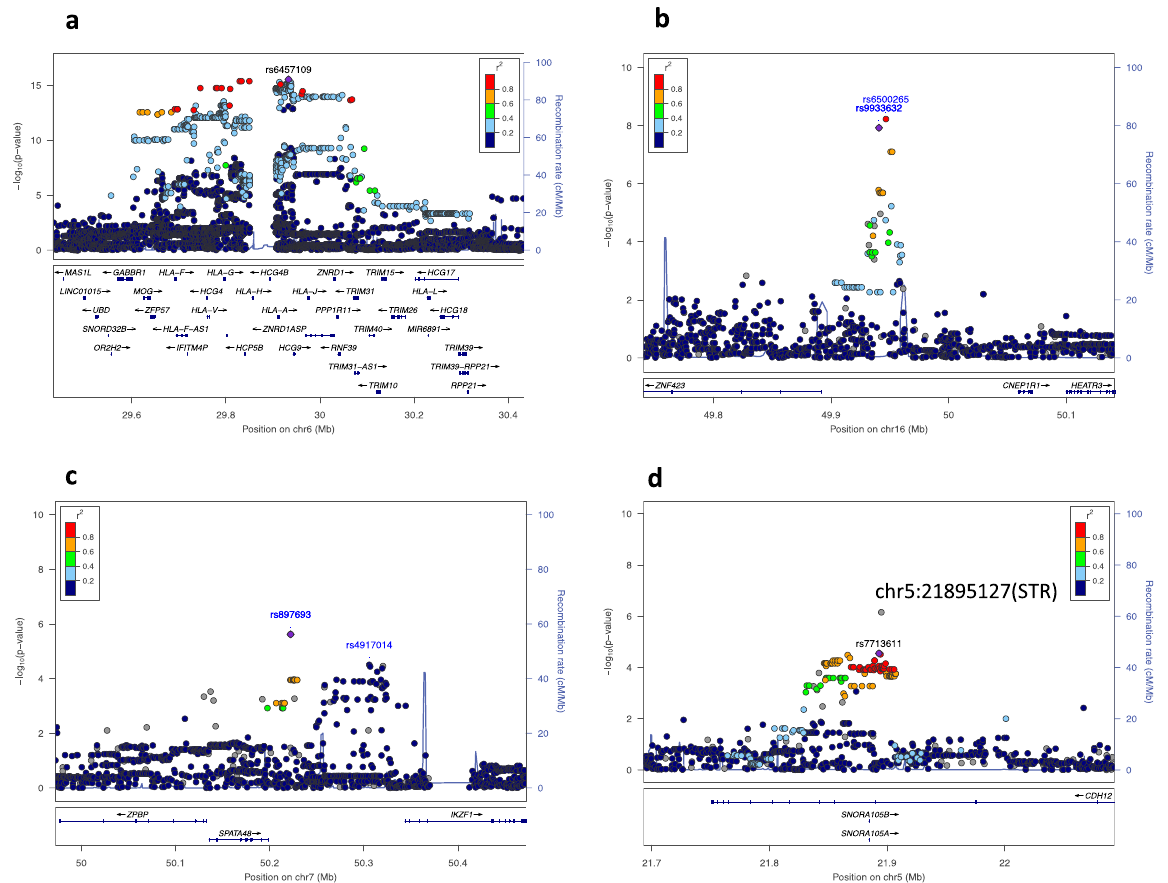
Fig. 2 Regional plots for loci with signi fi cant associations. Each panel represents the association of variants on four loci: a HLA-A gene, b chromosome 16q12.1, c IKZF1 gene, and d chromosome 5p14.3. Each variant is colored according to the strength of LD (r 2 ) with top hit variants, except for STRs, which are colored